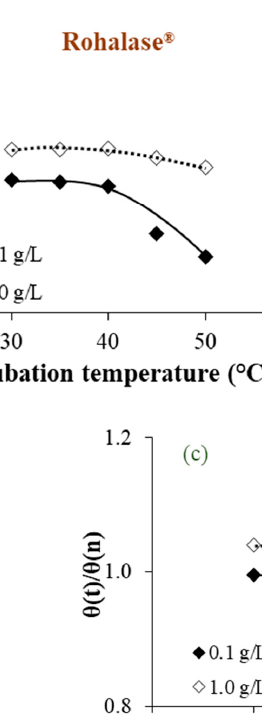
Figure 2. Dependence of the IEC(t) for the treated CMX-Sb on incubation temperatures and concentrations of Rohalase ® ( a ); Corolase ® ( b ), and Tyrosinase ® ( c ).